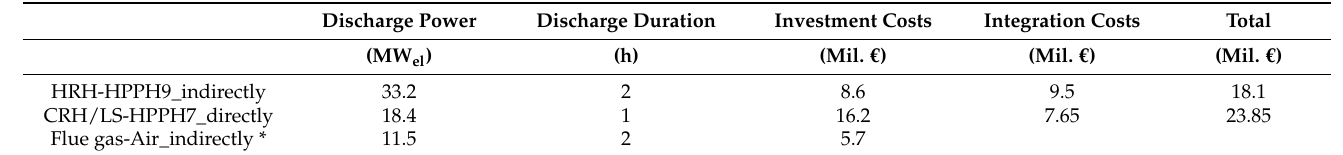
Table 11. TES Total costs for the selected optimal storage sizes.